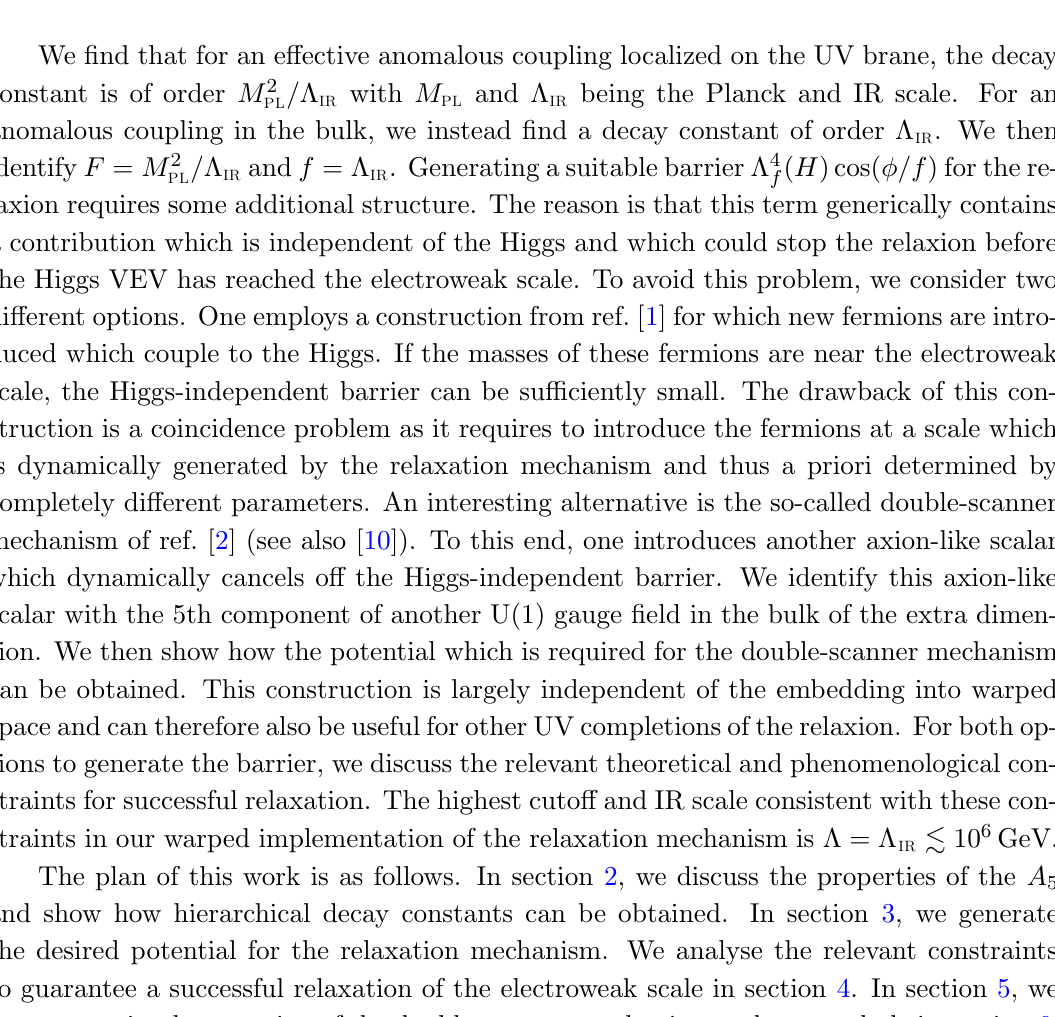
Figure 1 . A UV completion for the relaxion model is obtained by embedding the relaxion and the Higgs into a warped extra dimension. The hierarchy problem is then solved in two steps: the relaxation mechanism protects the Higgs mass up to the IR scale (which can be much larger than the electroweak scale) and from there warping provides protection till the Planck